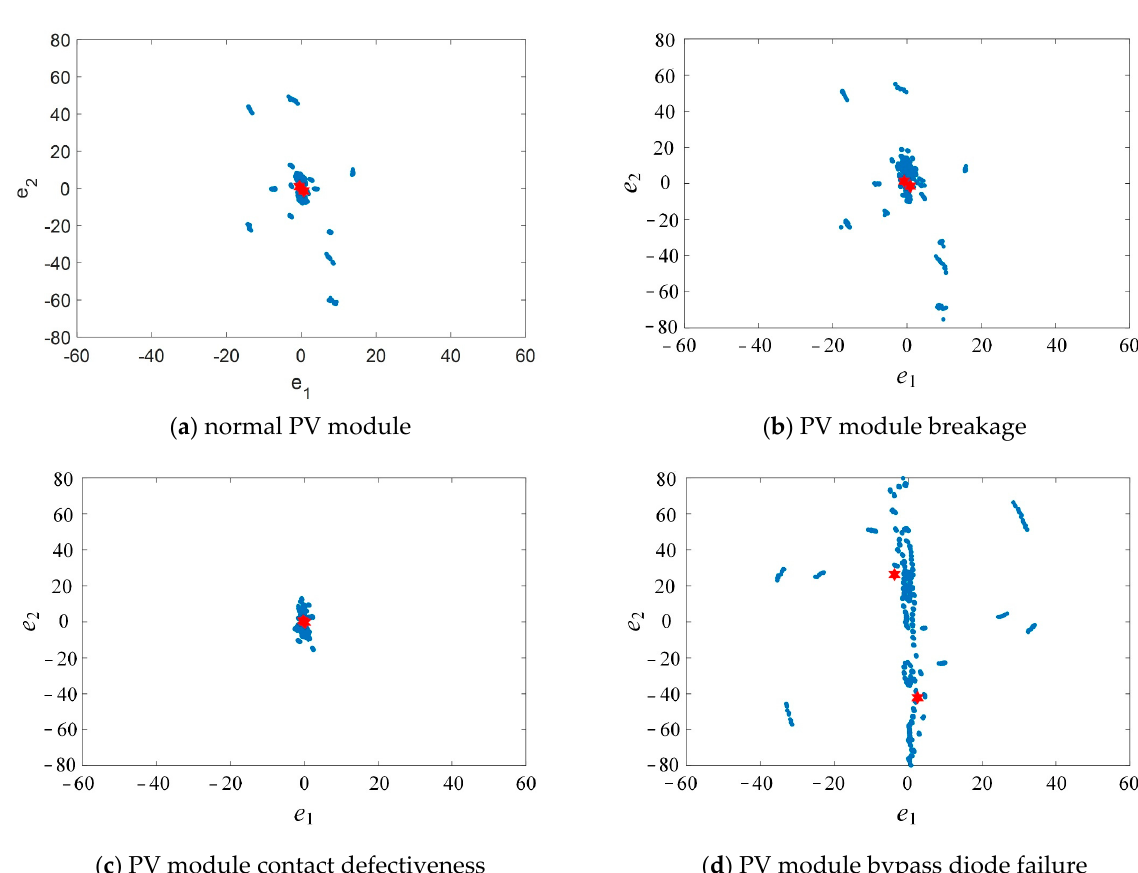
Figure 16. The integration of the original signals.